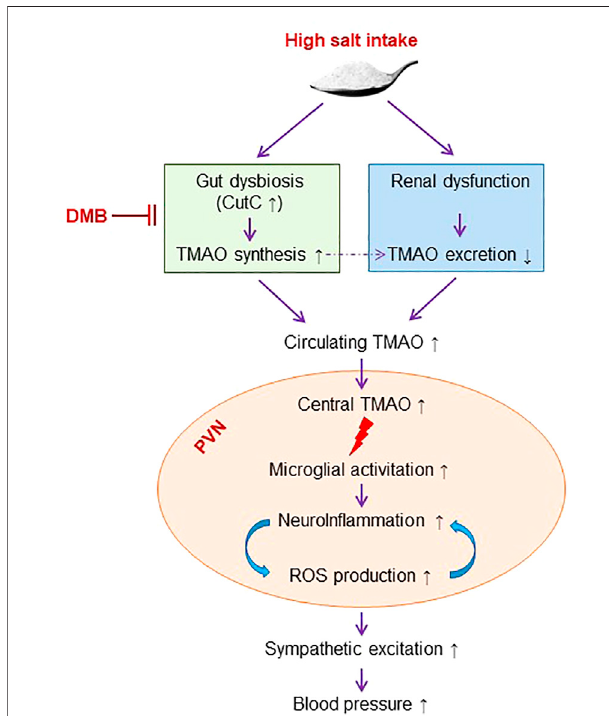
FIGURE 7 | Schematic diagram showing the mechanism by which high salt intake induces sympathetic excitation and hypertension and the inhibition of TMAO synthesis for the treatment of high salt-induced hypertension. TMAO: trimethylamine-N-oxide, a gut microbiota-derived metabolite. DMB: 3,3-Dimethyl-1-butanol, an inhibitor of trimethylamine formation. ROS, reactive oxygen species. CutC, choline trimethylamine-lyase; the bacterial genes encoding enzymes responsible for trimethylamine